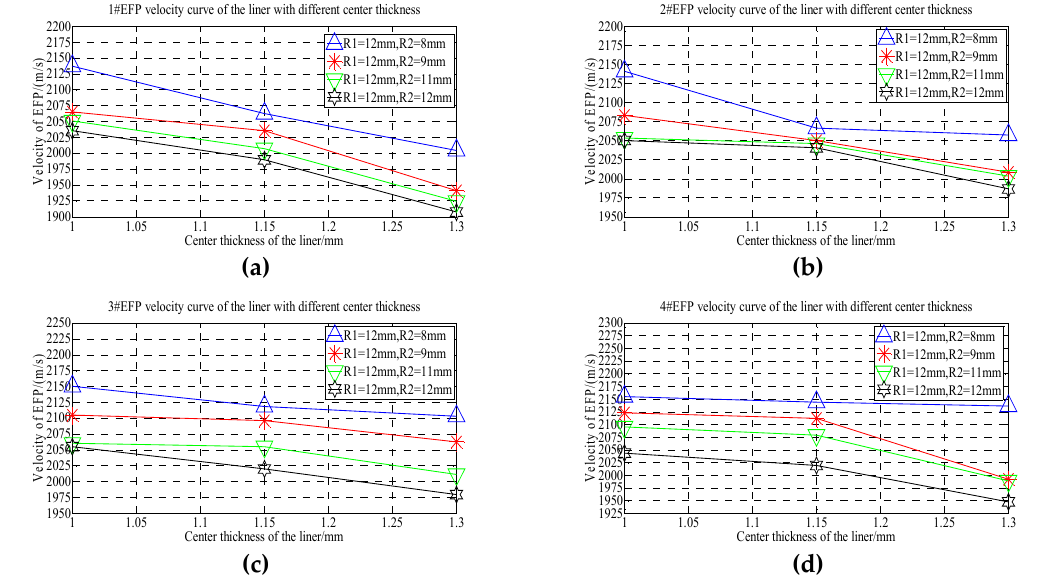
Figure 17. 1#EFP-4#EFP velocity curve of the center of the liner with different thickness: ( a ) 1#EFP velocity curve; ( b ) 2#EFP velocity curve; ( c ) 3#EFP velocity curve; ( d ) 4#EFP velocity curve.